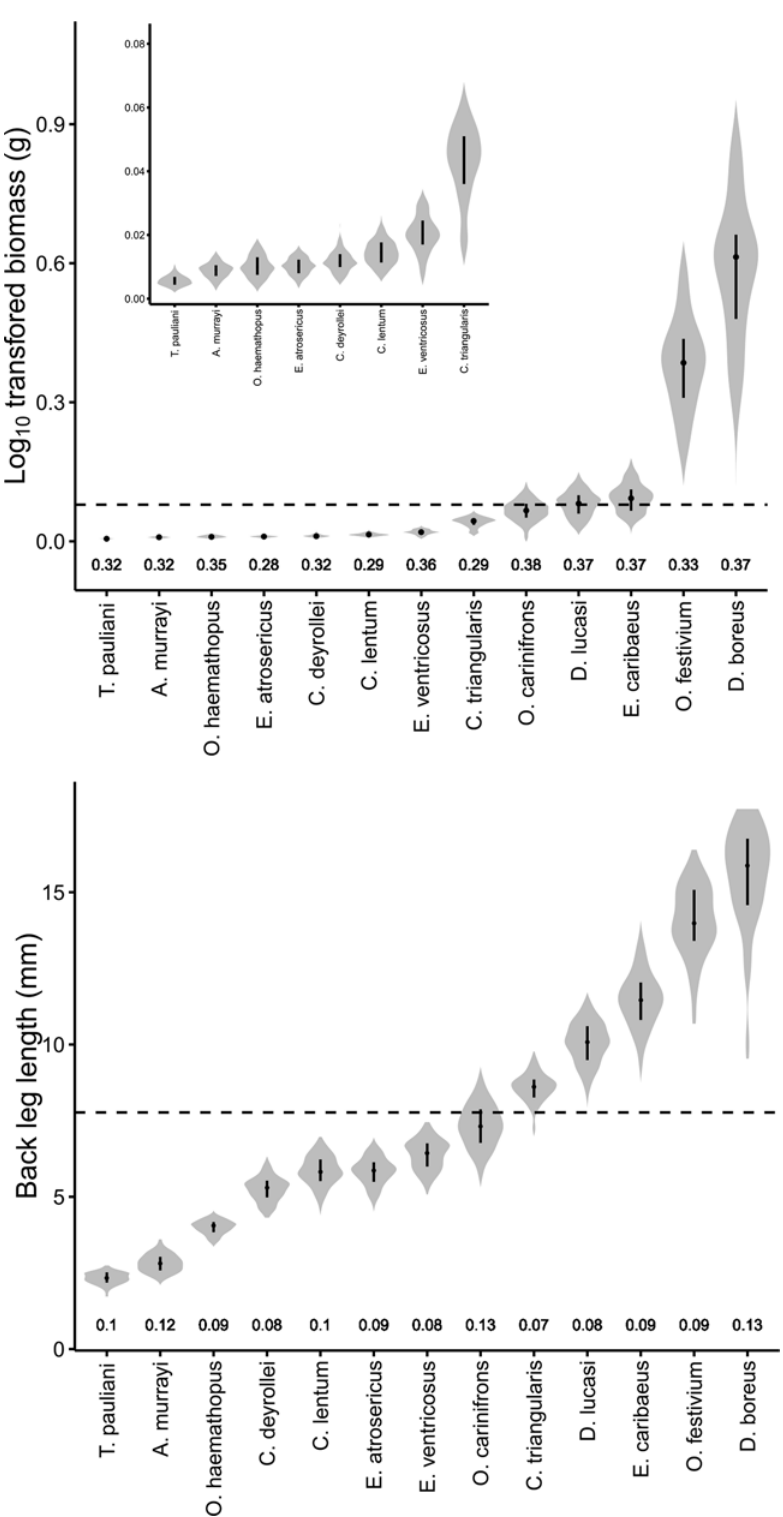
Fig 1. Extent of intraspecific variability in dung beetle body mass (a) and back leg length (b). Violin plots display (i) the density of data estimated by kernel method (grey areas); (ii) the median value (black horizontal dots in the centre of violins); and (iii) the interquartile range (between the top and bottom of the